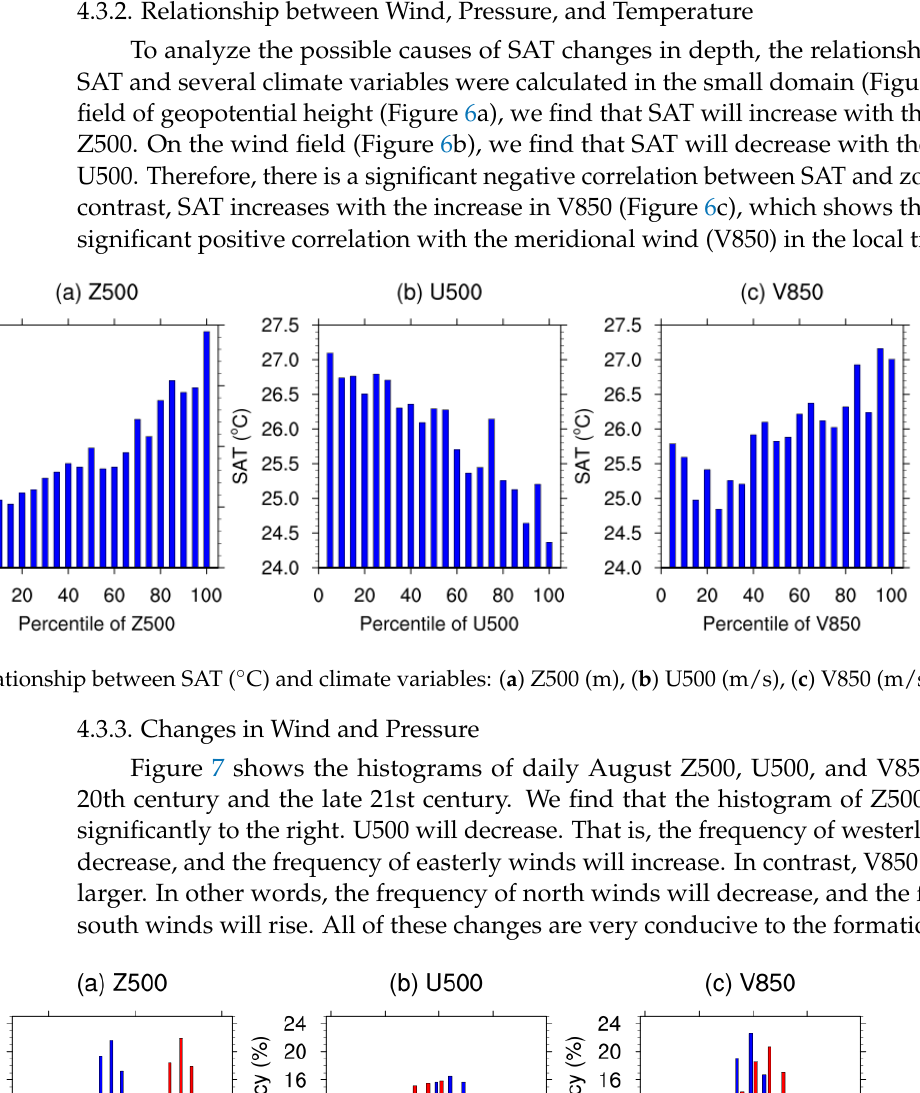
Figure 5. SAT (°C) changes in southeastern China at the end of the 21st century under future sce- narios (Representative Concentration Pathways 8.5 (RCP8.5)): ( a ) late 20th century, ( b ) late 21st cen- tury, ( c ) difference between the two periods.